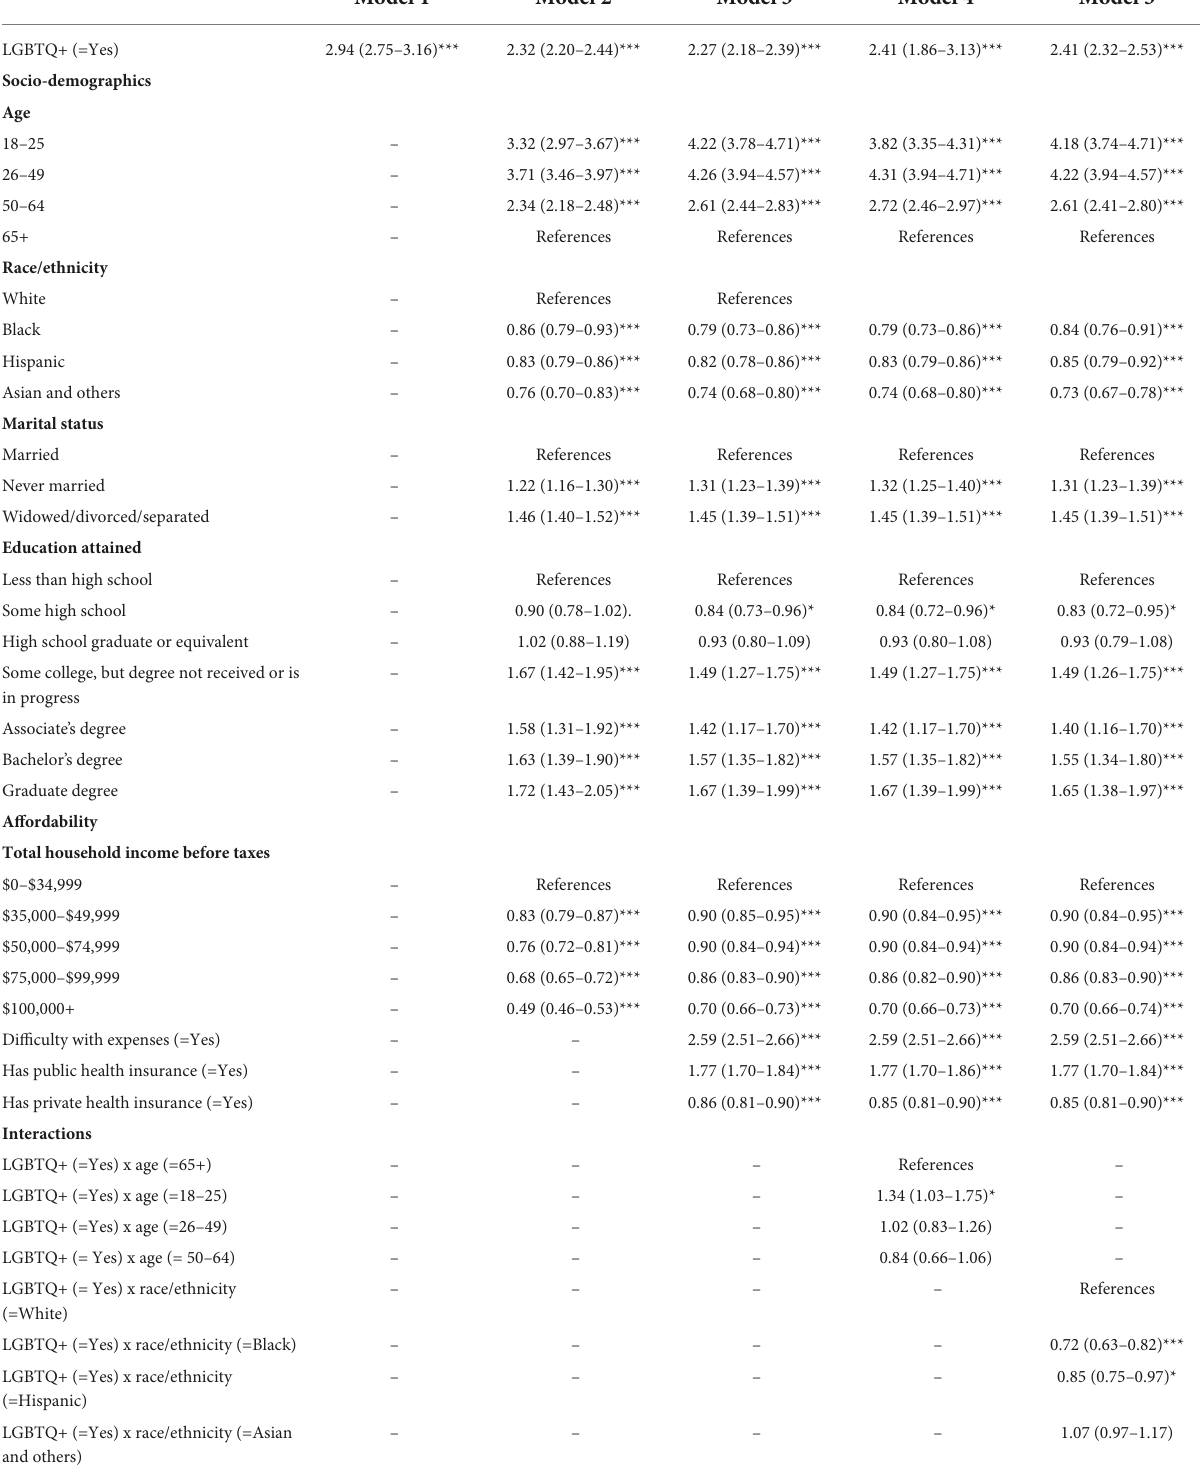
TABLE 2 Association between LGBTQ+ status and unmet mental health needs, as well as age and race/ethnicity disparities, from 21 July 2021 to 9 May